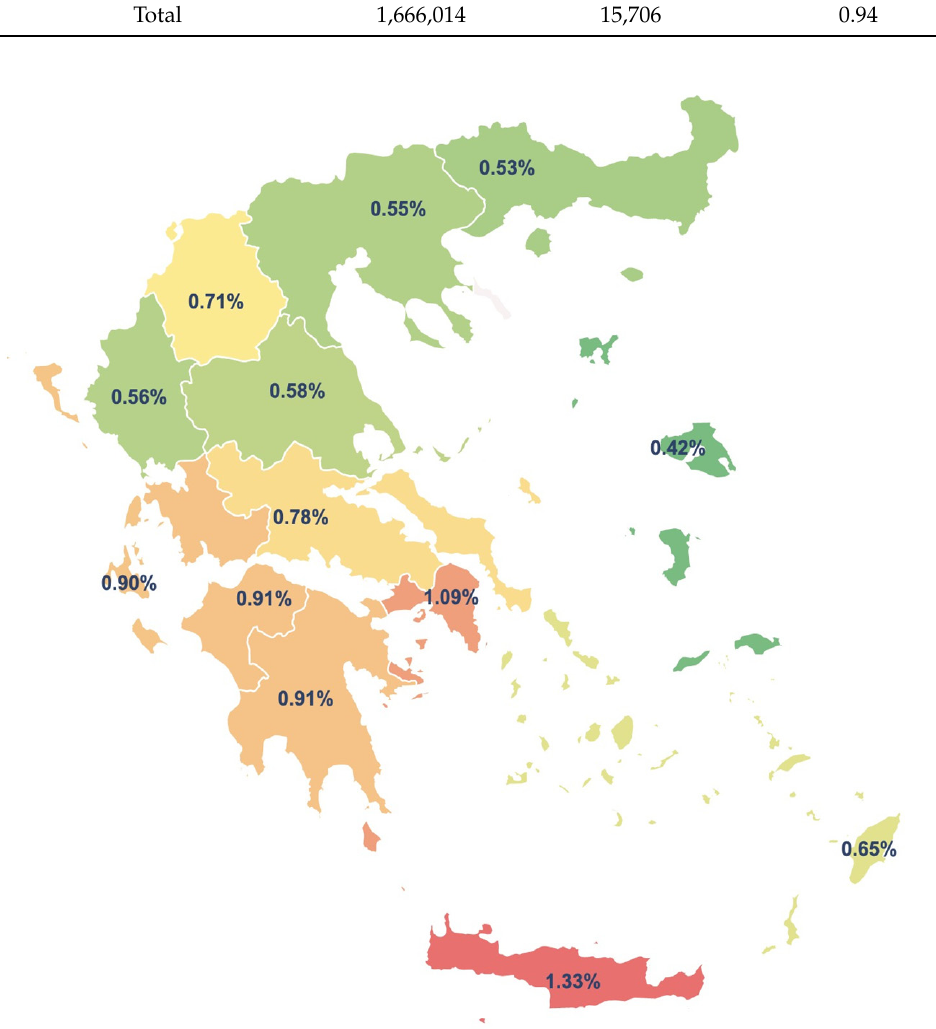
Figure 1. Prevalence of ASD per geographical region.